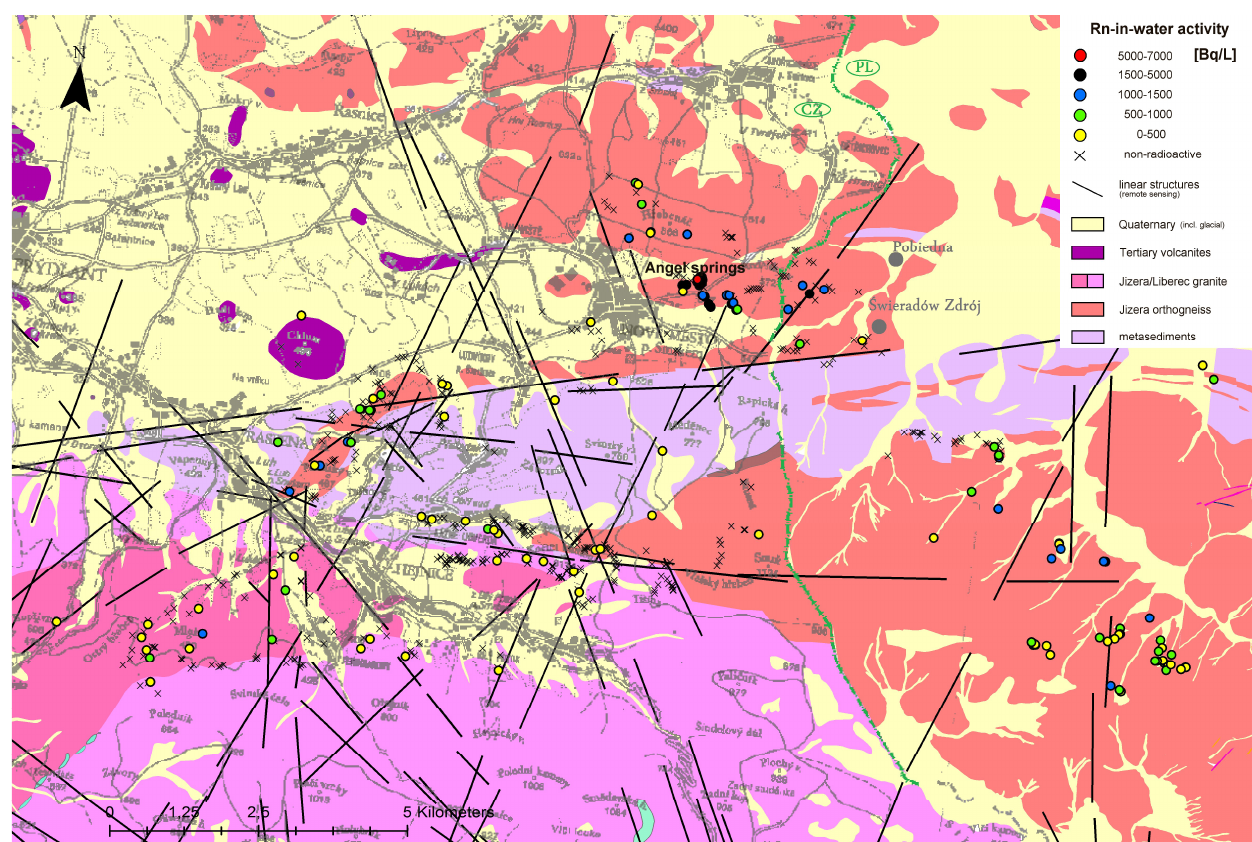
Figure 10. Radon-in-water activities in the Lázně Libverda–Świeradów-Zdrój area, Claim #3 (GIS composite)s.